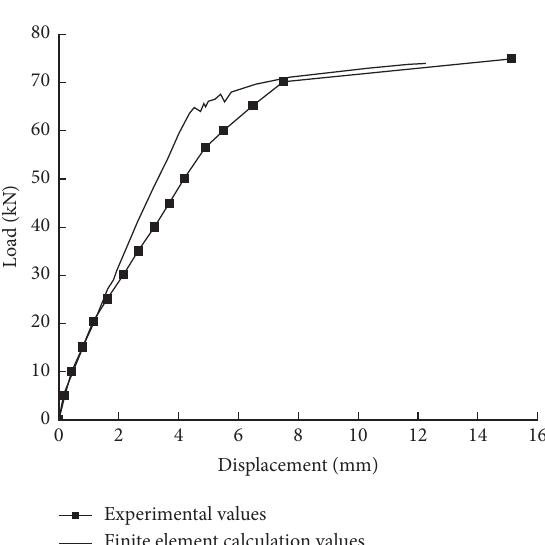
Figure 13: Load-deflection curve of test beam BM0-2.